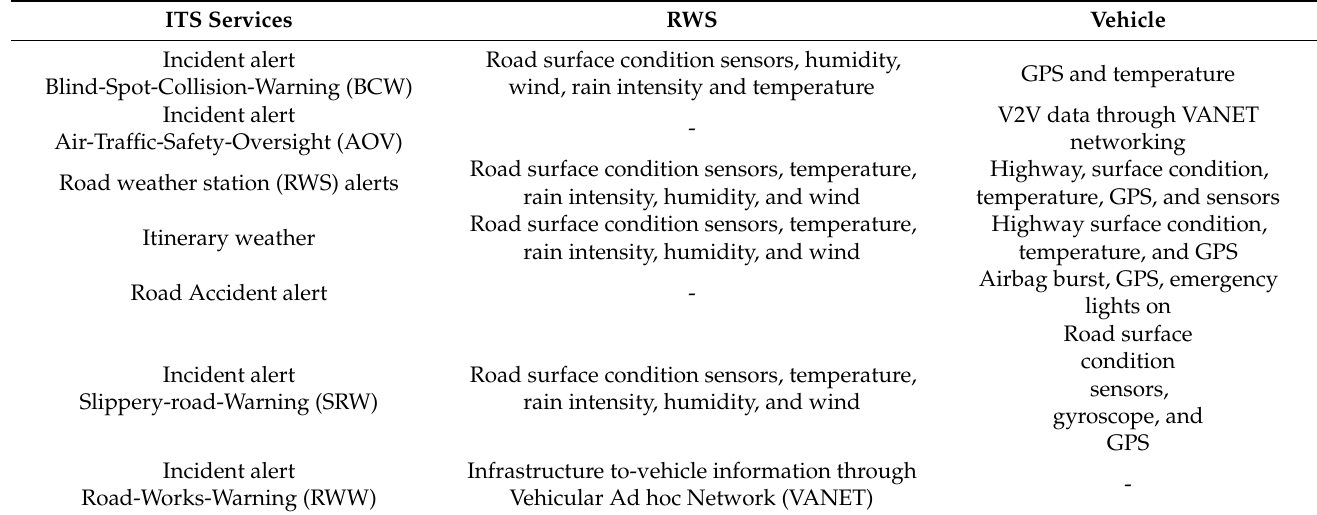
Figure 2. Road weather services tailored for pilot measurements of Intelligent Transport System (ITS)-G5 and 5G. Table 1. Advanced ITS road traffic service.